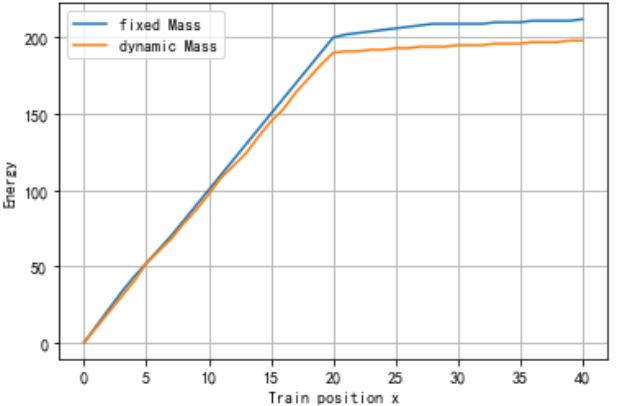
Figure 10. Energy consumption of fixed and online learning train mass value.